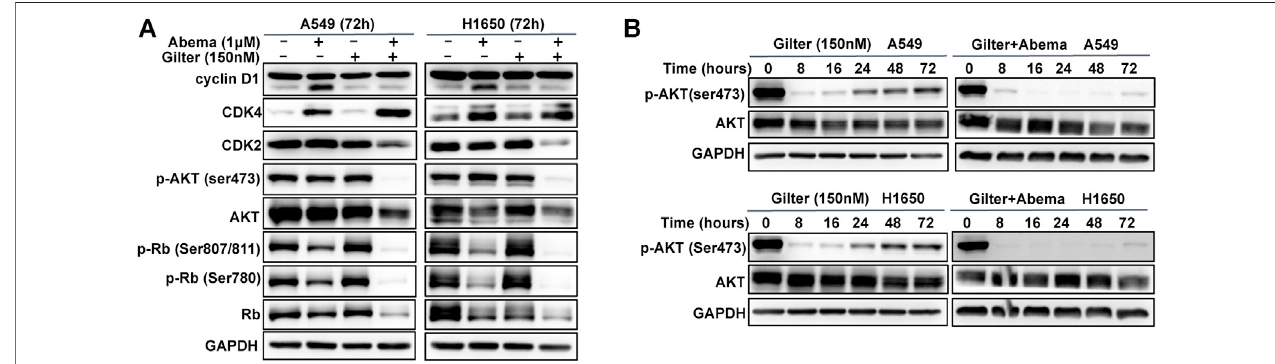
FIGURE 3 | Abemaciclib in combination with gilteritinib inhibits Rb and AKT pathways (A) A549, H1650 cells were treated by 1 μ M abemaciclib, or 150 nM gilteritinib alone,or theircombinationfor72 h,and Westernblotwasused todetermine theexpressions ofcyclinD1, CDK2, CDK4, p-AKT (ser473),AKT, p-Rb